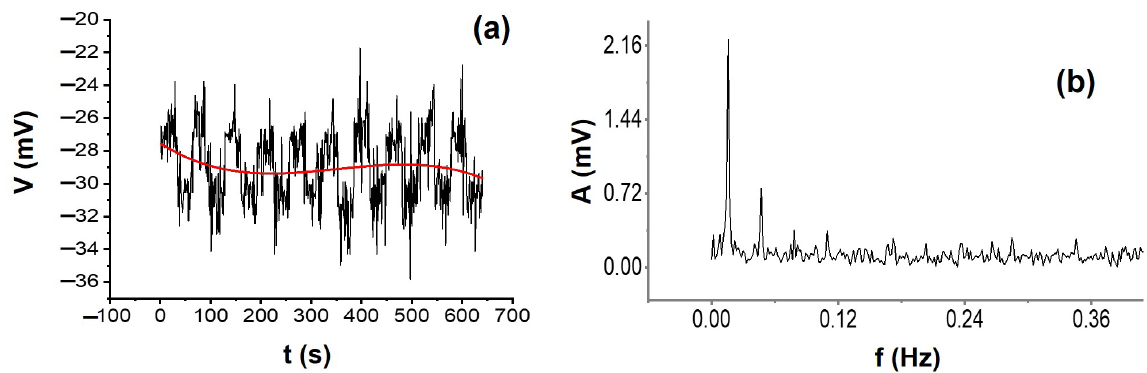
Figure 8. ( a ) Example of an electrical-potential-measured signal at the studied area. The red line represents a data polynomial trend. ( b ) Detrended electrical potential data in the frequency domain.